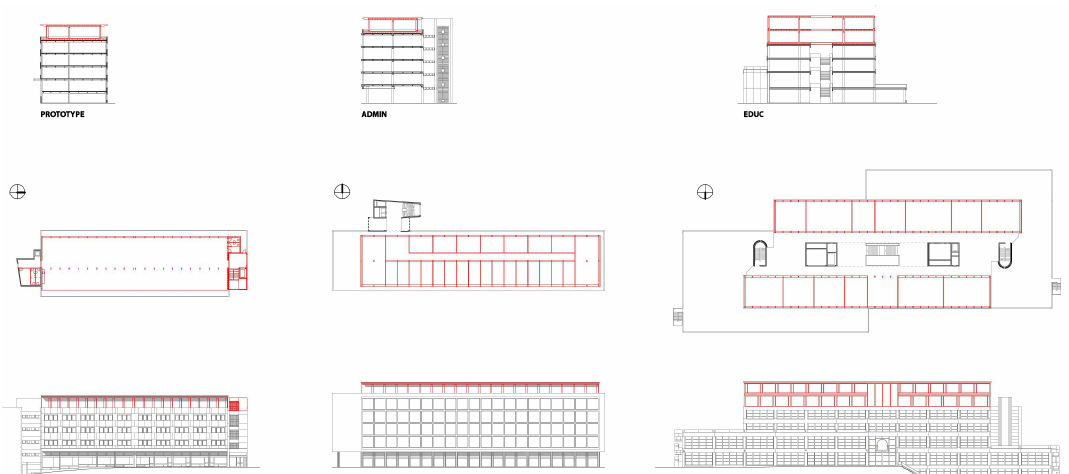
Figure 1. Different building configurations studied during the system’s development to check its adaptability to various dimensions of pre-existing structural grids, façade designs and orientations. Elements in red refer to the new construction, while elements in black refer to the existing building.